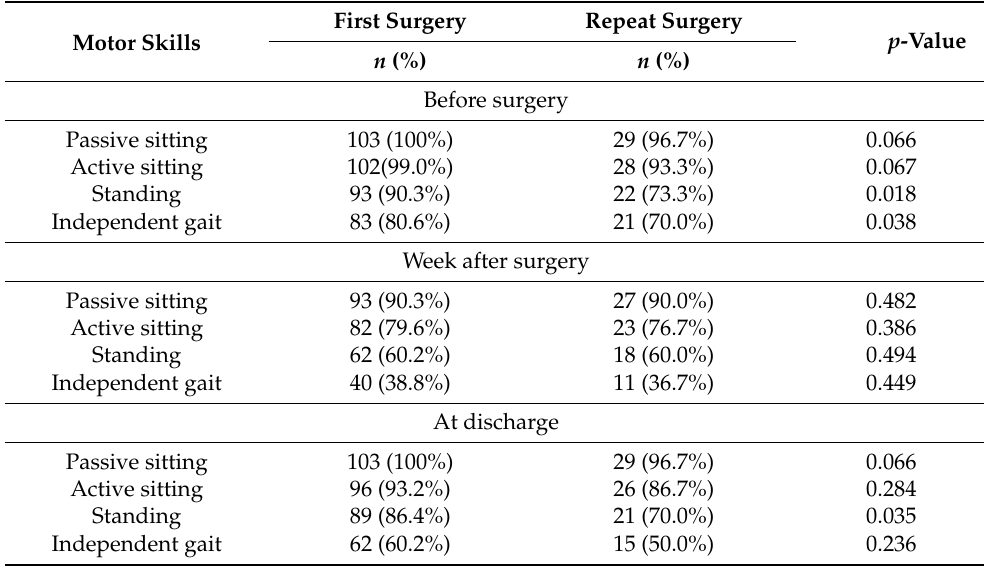
Table 5. Functional state before surgery, a week after surgery, and at discharge ( n = 133). Motor